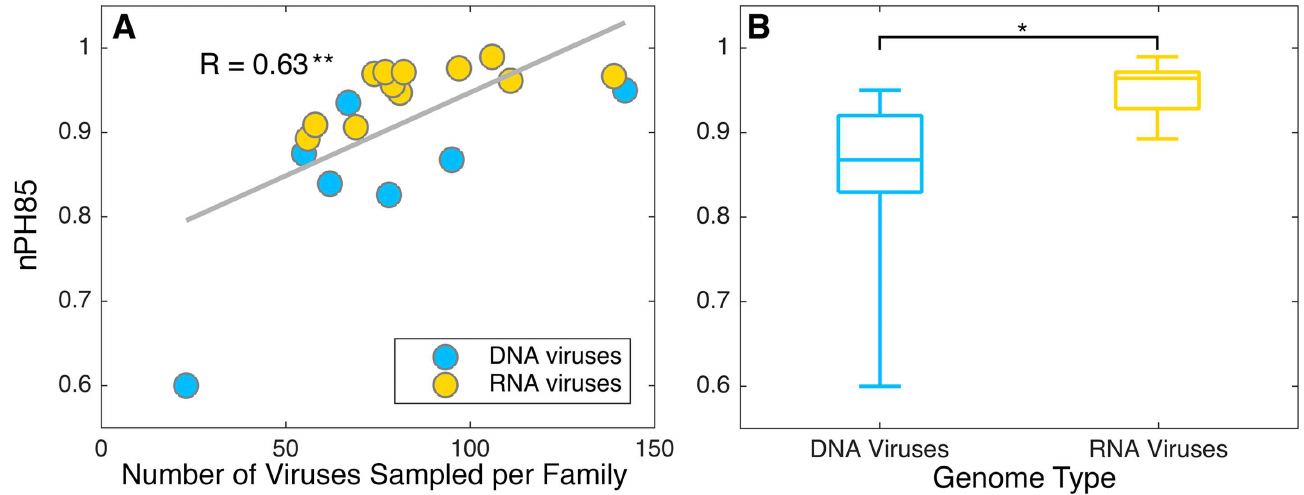
Fig 6. (A) The nPH85distanceas a function of the numberof viruses per virus family. Pearson’scorrelationcoefficient, R, was found to be statistically significant(p < 0.005). (B) nPH85 distancesby genometype showingthe median(horizontalline) and 25 th and 75 th percentiles. A t-test showedthat the difference betweenthese distances was significant(p < 0.05). As before, a range of DNA (blue) and RNA (yellow)virus families are